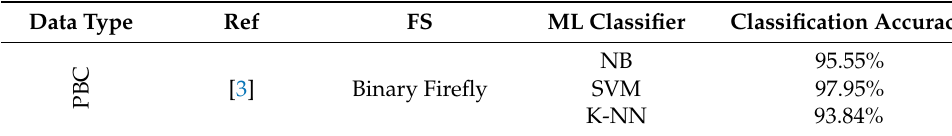
Table 3. ASD prediction using ML with optimized